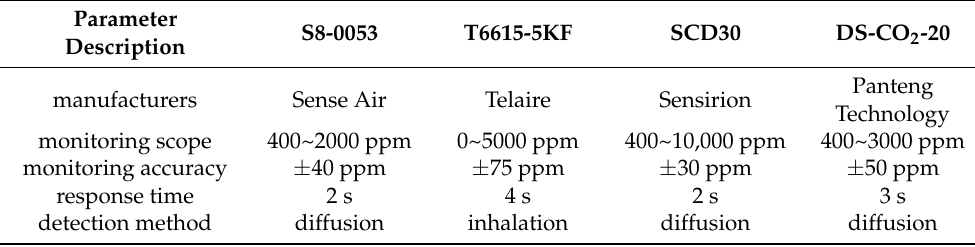
Table 3. CO 2 sensors performance